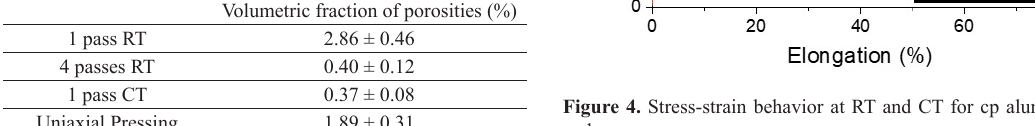
Figure 4. Stress-strain behavior at RT and CT for cp aluminum and cp copper.